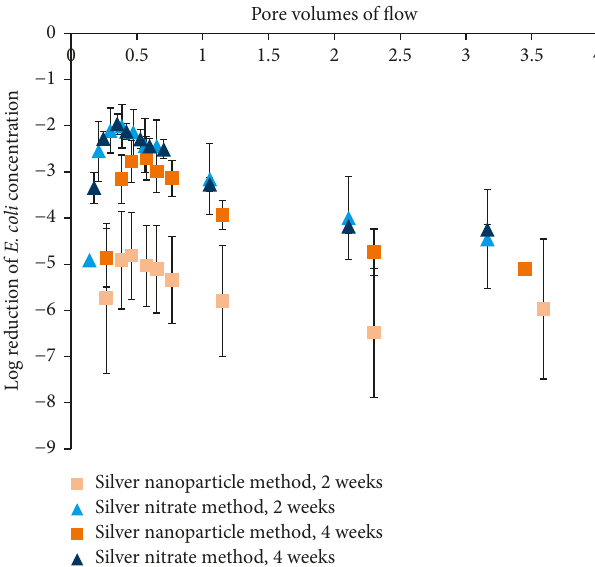
Figure 7: Average log change of E. coli , Log( C / C volume after a pulse injection of E. coli over 1 min by silver ap- plication method and time of saturation. Error bars show one standard error above and below the